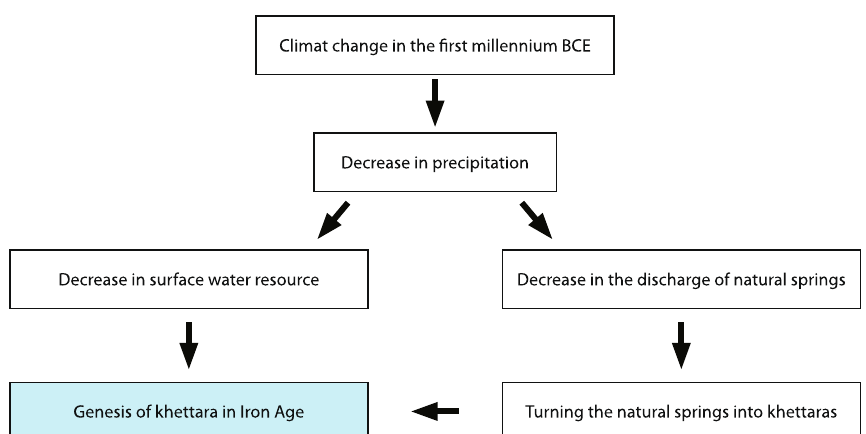
Fig. 2 Relations between the climate and techniques that led to the invention of khettara (qanat) technology throughout the world (Source: Labbaf Khaneiki